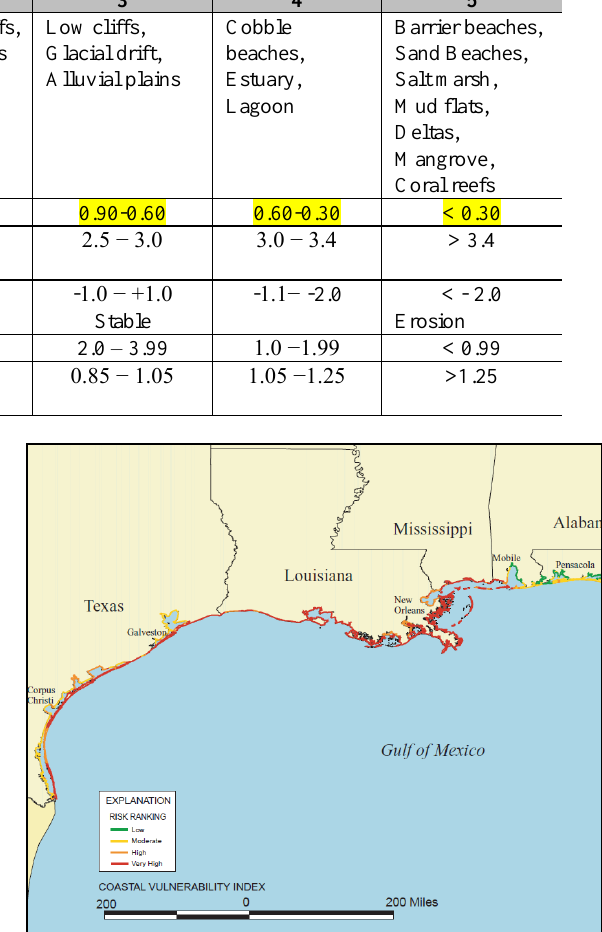
Figure 3. Map of the Coastal Vulnerability Index (CVI) for the U.S. Gulf coast (Thieler and Hammar-Klose, 2001) Ultimately, at Northern Ireland Index level, the East Strand at Portrush is classified as being predominantly in the 40-60 vulnerability category, decreasing to 20-40 at regional level, at local scale, the beach is predominantly in the vulnerability range 0-20.